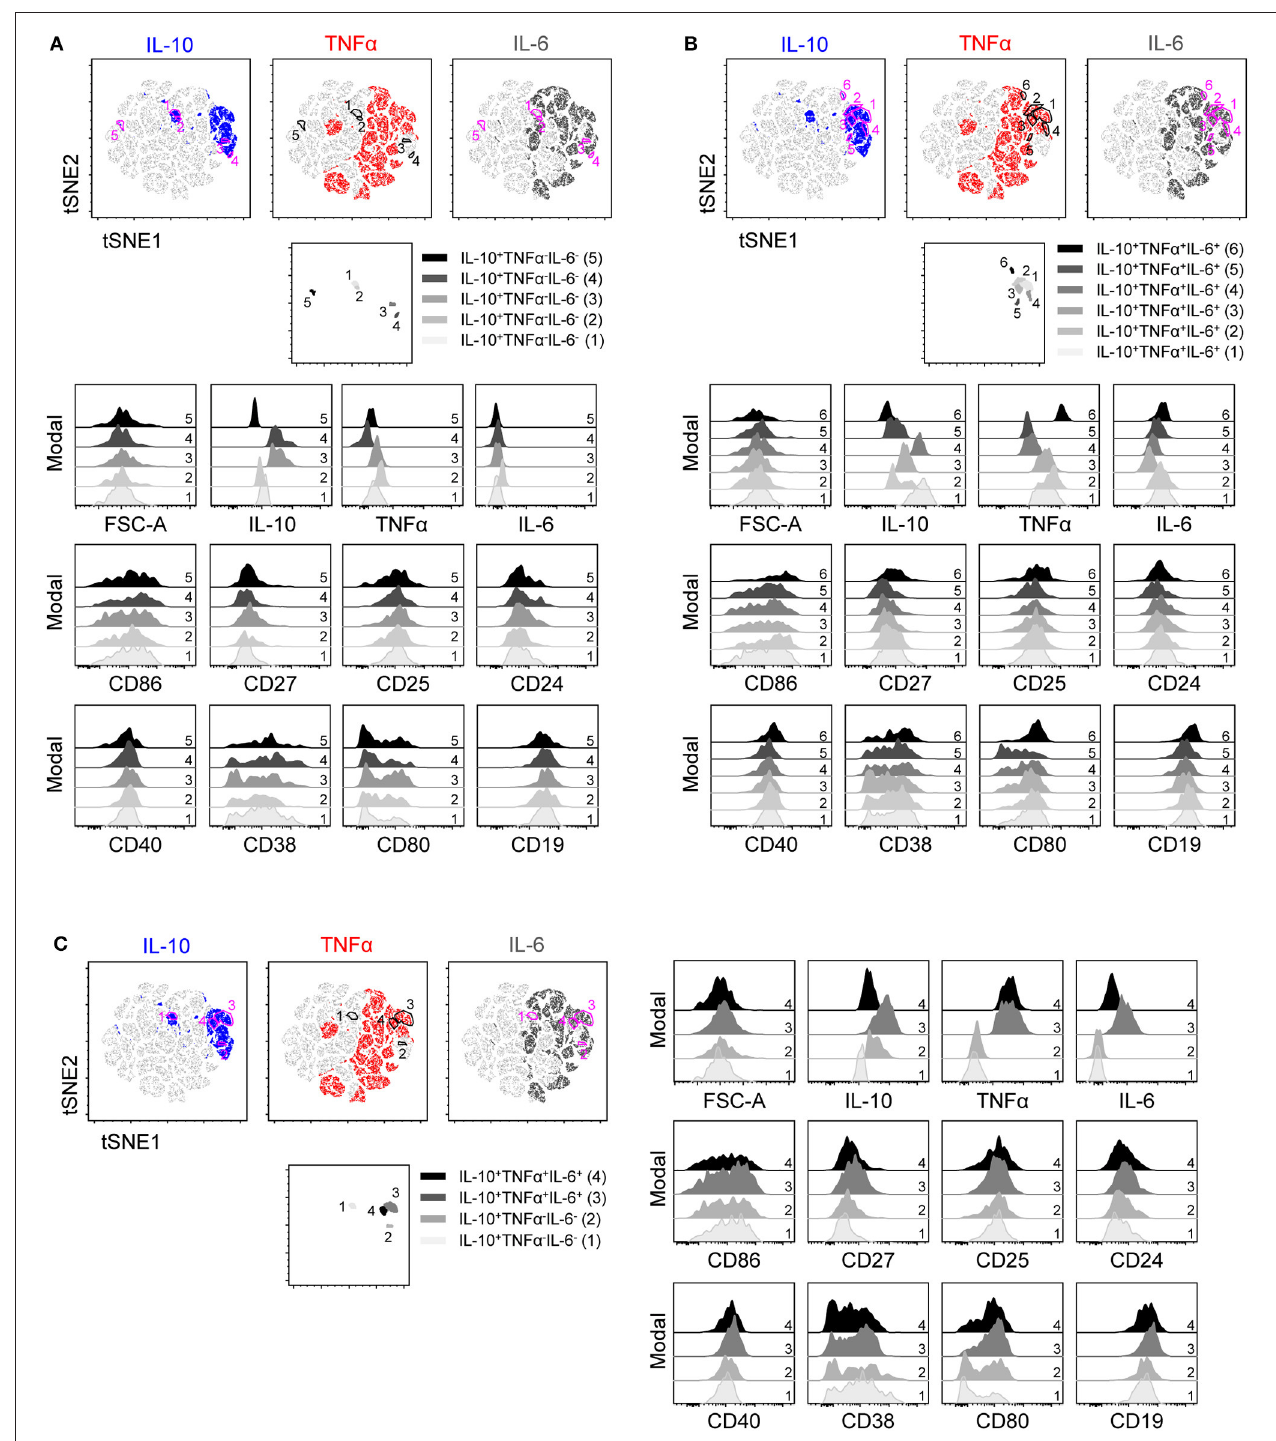
FIGURE 3 | t-SNE clustering on IL-10, TNF α , and IL-6 within B cells stimulated with CpG for 2 days and the expression of co-stimulatory markers. t-SNE 2D scatter plot of 91,000 living single CD19 + B cells stimulated for 2 days with CpG and stained with staining mixture 1 containing antibodies against IL-10, TNF α , IL-6, CD86, CD27, CD25, CD24, CD40, CD38, CD80, and CD19 ( n = 7). t-SNE settings were as followed: perplexity 70; theta 0.5; eta 200 and iterations 1,000. IL-10, TNF α , and IL-6 were selected as t-SNE parameters. Different colors depict the IL-10 + (blue), TNF α + (red) and IL-6 + (dark gray) B cells. (A–C) Five IL-10 + TNF α − IL-6 − (A) , six IL-10 + TNF α + IL-6 + (B) , and two IL-10 + TNF α − IL-6 − and IL-10 + TNF α + IL-6 + (C) B cells were gated within the t-SNE 2D scatter plot, selected populations are depicted in a separate t-SNE 2D scatter plot and expression of various markers within these populations (represented as color spectrum of gray and black) were depicted in half-off set histograms.